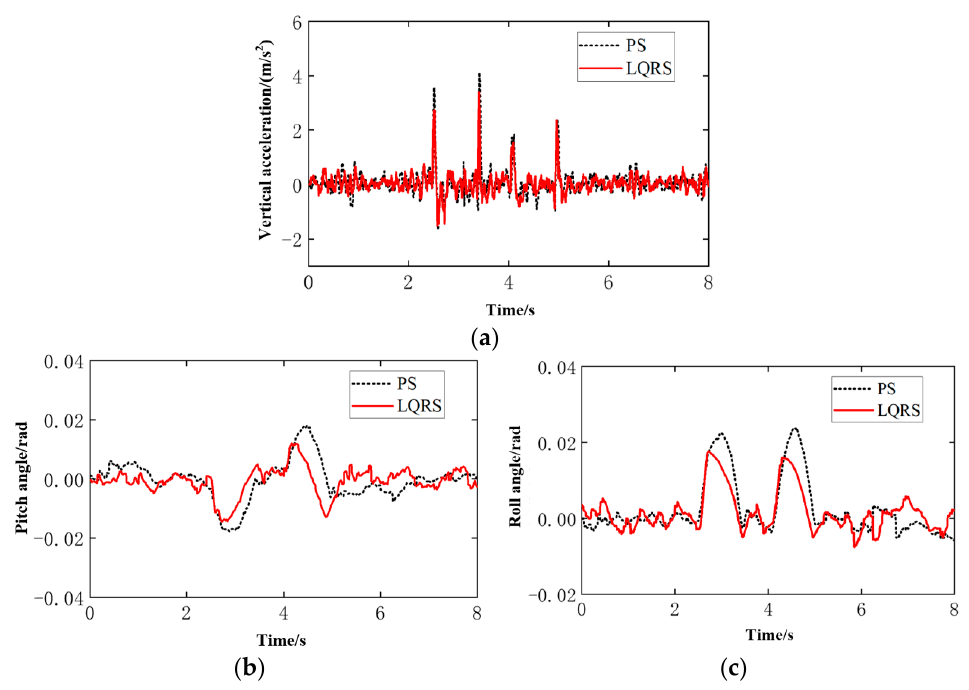
Figure 12. Experimental results of MPCS under the bump road disturbances: ( a ) Heaving accelera- tion of car body; ( b ) Pitching angle of car body; ( c ) Rolling angle of car body.